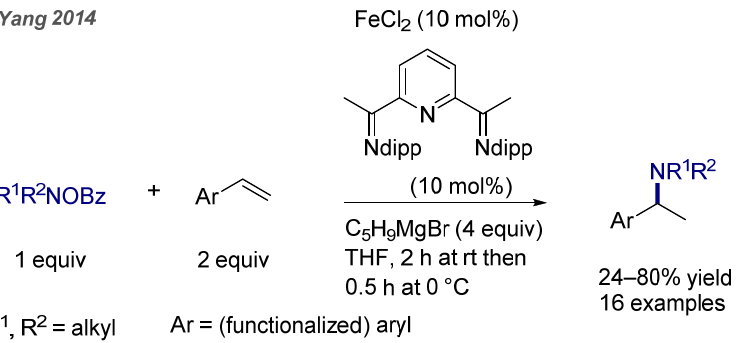
Figure 8. Markovnikov selective iron-catalyzed hydroamination of vinylarenes with hydroxylamine esters. rt = room temperature.